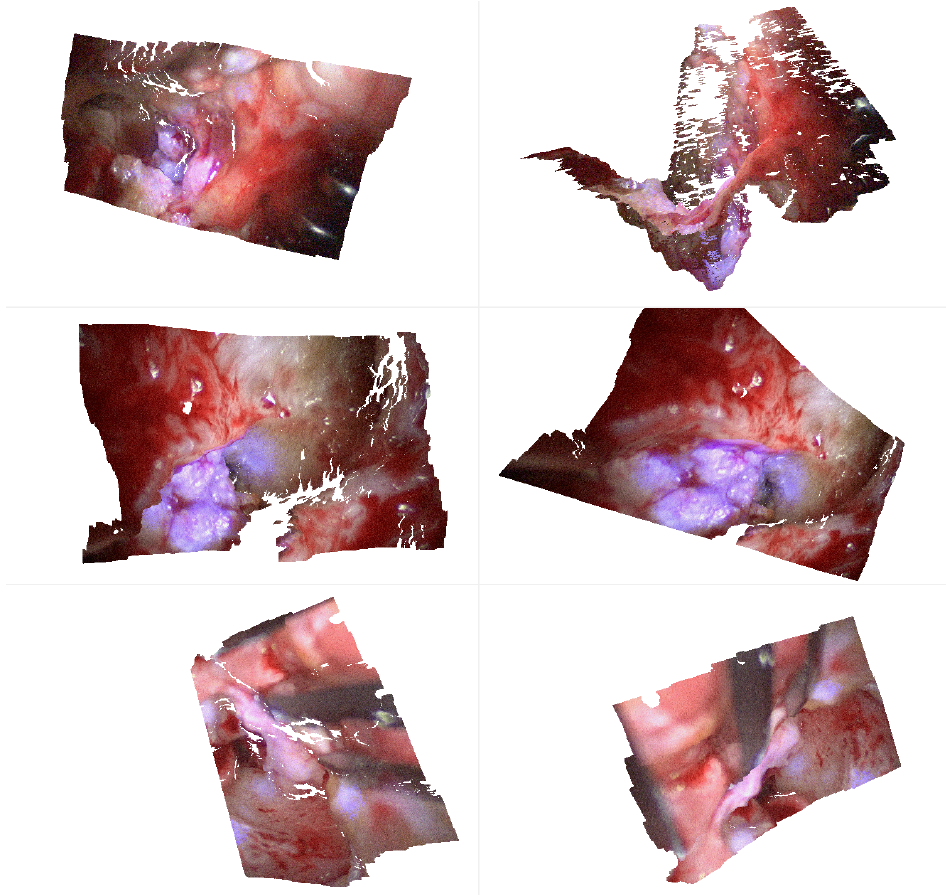
Figure 13. 3D reconstructed spectral point cloud indicating spatial and depth related spread of cholesteatoma tissue. The point clouds consist of approximately 1.8 million vertices. Gaps in the 3D model occur from occlusion and missing stereo correspondences. ( Top row ) Patient #1; ( Middle row ) Patient #2; Bottom row ) Patient #3.